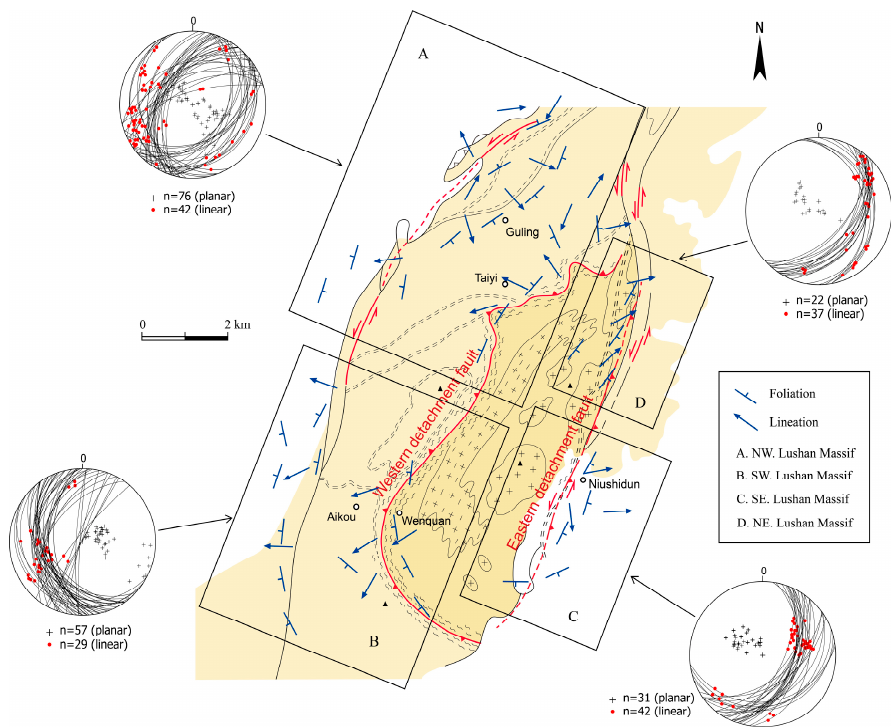
Figure 6. The planar and linear structural elements of extensional structures in the Lushan Massif.